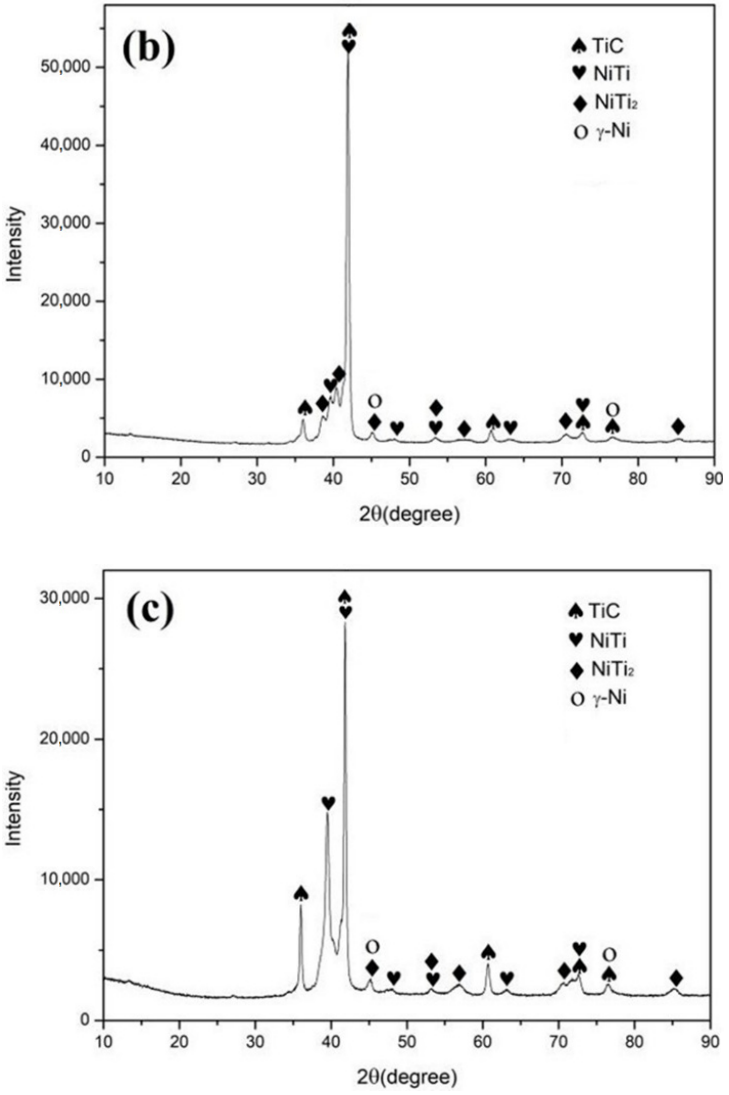
Figure 3. XRD patterns of the coatings: ( a ) ν = 12 mm/s, ( b ) ν = 15 mm/s and ( c ) ν = 18 mm/s. According to the curve of the change of standard Gibbs free energy ( ∆ G) of reactions 1, 2 and 3 with the temperatures shown in Figure 4, the ∆ G of reactions 1, 2 and 3 are negative in the temperature range of 400 K to 3200 K, indicating that both chemical reactions can proceed spontaneously in the molten pool. The TiC phase is preferentially precipitated in the molten pool according to the Gibbs free energy theory of reactions, i.e., the smaller the ∆ G value, the stronger the thermodynamic driving force of the reaction and the easier it is for it to occur. Since TiC has a NaCl-type face-centered cubic crystal structure, it is easy to form particles or grow into dendrites. Ti and Ni are more likely to form NiTi and NiTi 2 [37], which is consistent with the XRD results in Figure 3. The matrix of the coating comprises γ -Ni, distributing NiTi, NiTi 2 and a TiC ceramic-reinforced phase. All three reaction products have a higher hardness compared to the substrate, which is beneficial to improving its hardness and wear resistance. It is clear that TiC is more readily generated during the alloying